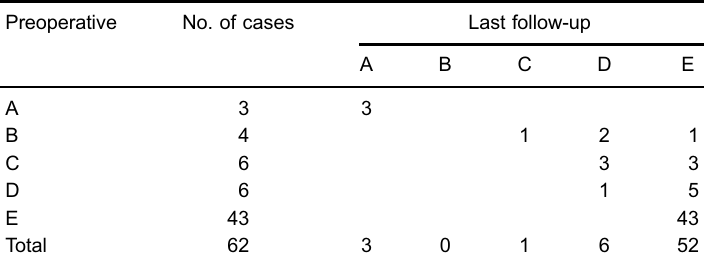
Table 2. Preoperative and last follow-up Frankel grades of a group of patients with Denis type B thoracolumbar burst fracture with neurological de fi ciencies treated with paraspinal-approach reduction and fi